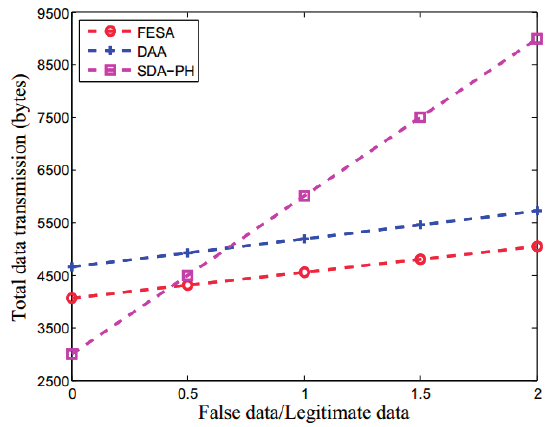
Figure 8. The total data transmission for FESA, DAA and SDA-PH, where in FESA and DAA detect false data during data aggregation and forwarding while SDA-PH detects only in